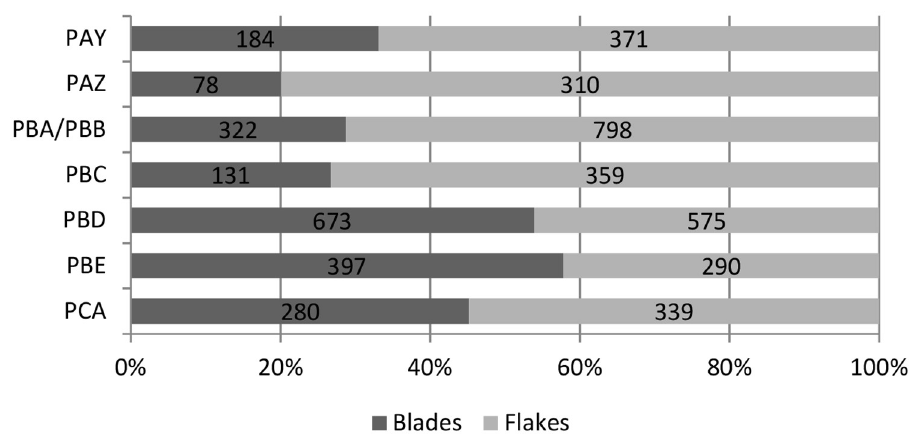
Fig 5. Proportions of blades and flakes in each layer of KDS, excluding core management flakes and blades.